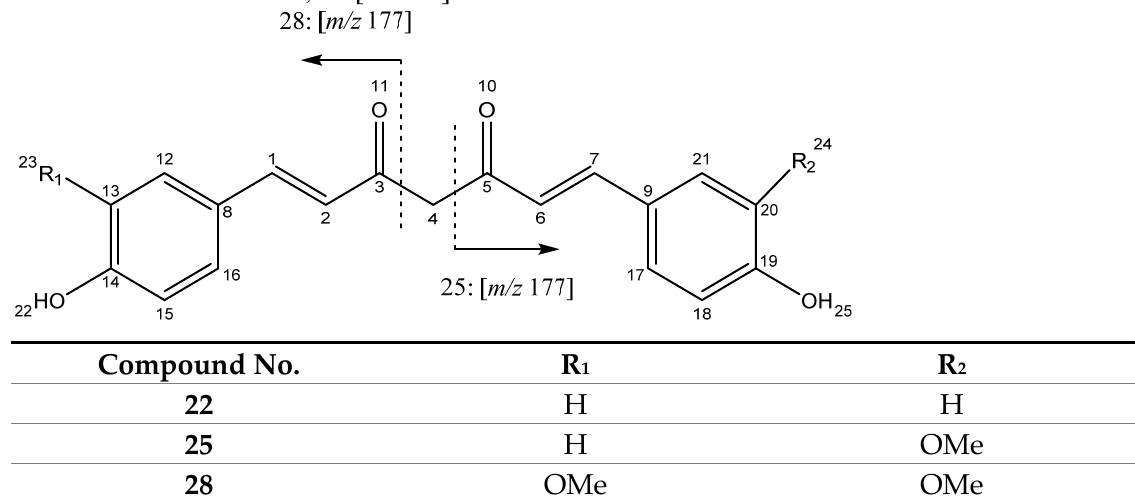
Figure 3. Fragmentation pathway of compound 4 . Peaks 14 (Rt = 15.52 min) and 18 (Rt = 16.46 min) were tentatively assigned to 1-(4- hydroxyphenyl)-7-phenylhept-1-ene-3,5-dione at [M + H] + at m/z 295.1313 (C 19 H 19 O 3 ) and 7-(3,4-dimethoxyphenyl)-1-(4-hydroxyphenyl)hept-1-ene-3,5-dione at [M + H] + at m/z 355.1512 (C 21 H 23 O 5 ), respectively. Meanwhile, peak 24 (Rt = 18.43 min) at m/z 341.1379 (C 20 H 21 O 5 ) was tentatively assigned to dihydrodemethoxycurcumin. All of these peaks hold a positive charge on C5, present a double bond between C1–C2 and show a product ion at m/z 147, which then undergoes a loss of carbon monoxide (28 uma) to produce the fragment observed at m/z 119, as shown in Figure 4 [27,28].